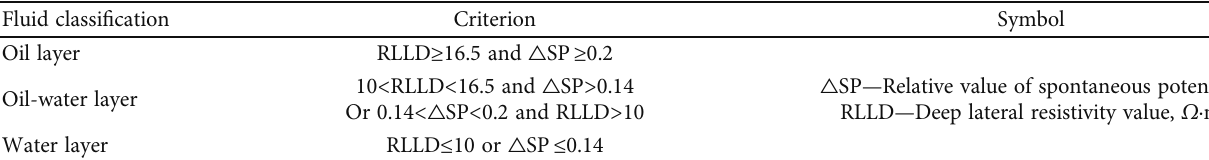
Table 5: Discrimination standard table.